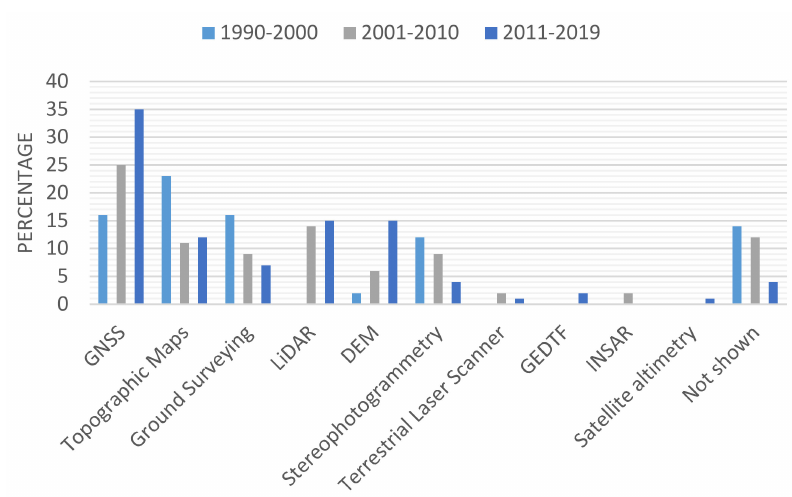
Figure 8. Temporal percentage distribution of reference data